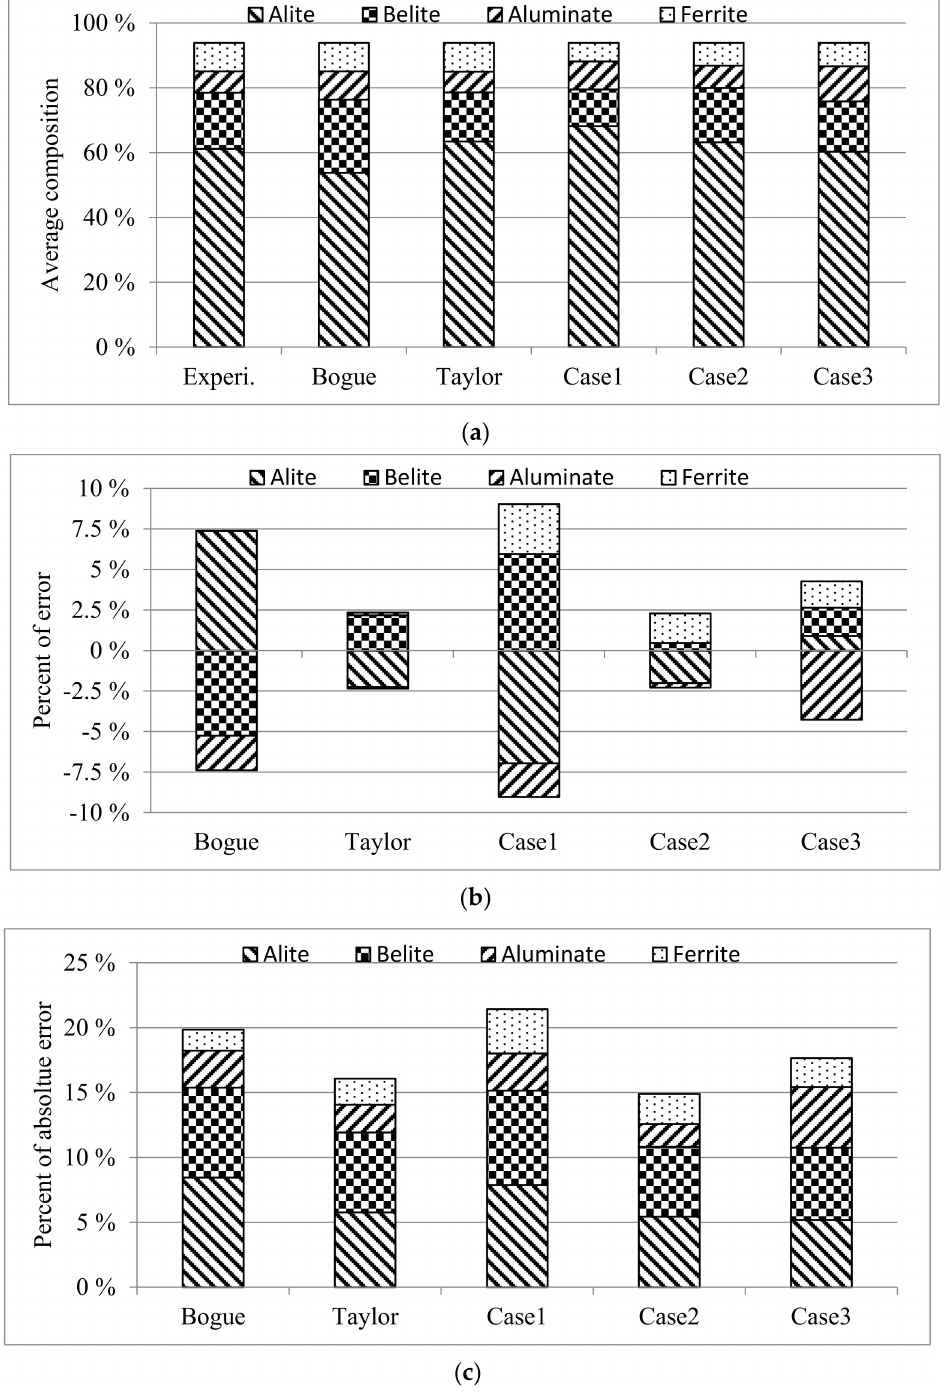
Figure 3. Results obtained experimentally and with the Bogue, Taylor, and Case 1–3 models: ( a ) aver- age values of 50 experimental data sets and calculated results; ( b ) the average differences between experimental data sets and calculated results; ( c ) the average absolute differences between experi- mental data sets and calculated